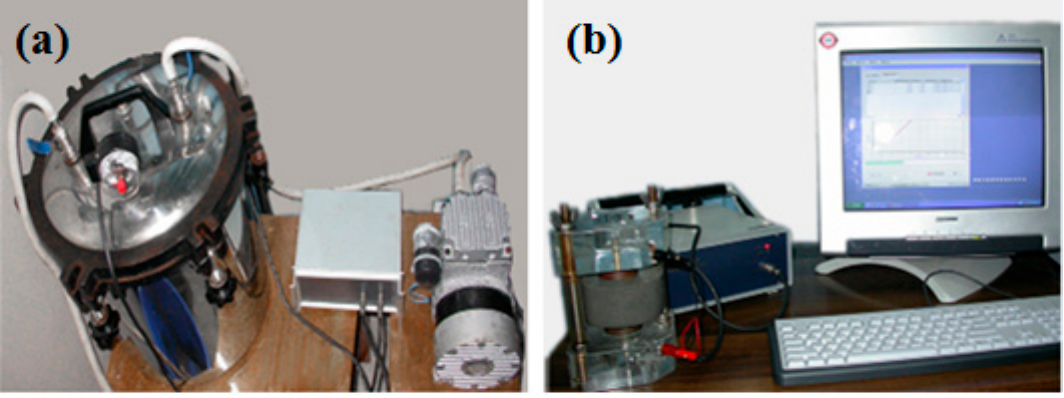
Figure 2. Instrument used in the chloride permeability test. ( a ) Brine saturation device under vacuum; ( b ) test equipment.